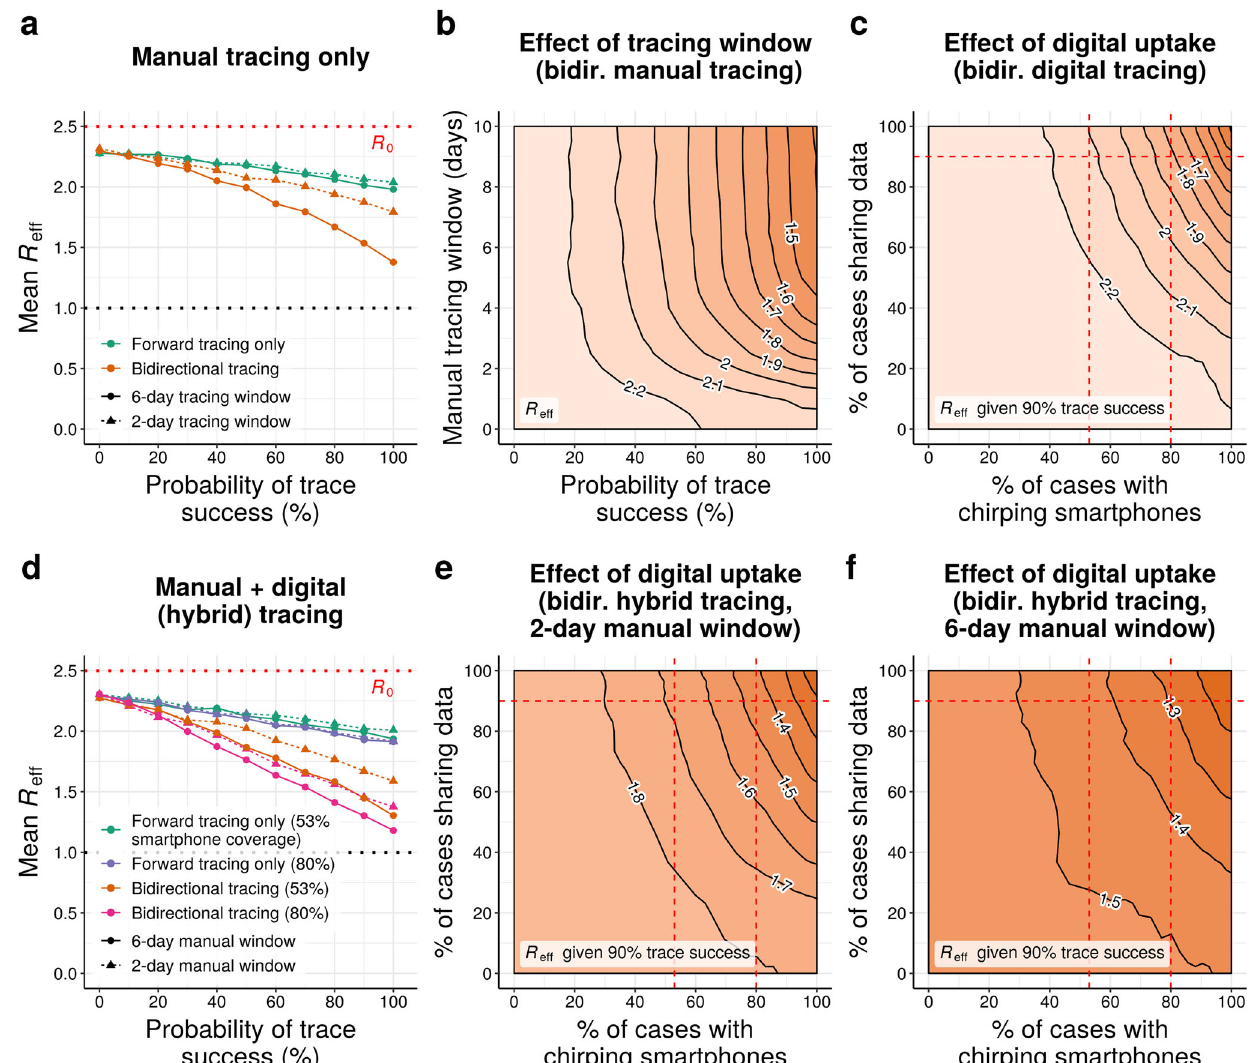
Fig. 2 Comparing forward and bidirectional contact tracing at R 0 = 2.5. a Mean R eff achieved by manual tracing with 2-day and 6-day manual tracing windows. b Neighbor-averaged contour plot, showing mean R eff achieved by bidirectional manual tracing as a function of the probability of trace success and the width of the manual tracing window. c Neighbor-averaged contour plot, depicting R eff achieved by digital exposure noti fi cation in the absence of manual tracing as a function of smartphone coverage and data-sharing, assuming 90% probability of trace success. d Mean R eff achieved using hybrid manual + digital tracing, assuming 90% data sharing and 53% or 80% smartphone coverage. e , f Neighbor-averaged contour plots, depicting R eff achieved by hybrid tracing as a function of smartphone coverage and data-sharing, assuming 90% probability of trace success and a e 2-day or f 6-day manual tracing window. All panels assume median disease parameters (Table 1). “ Probability of trace success ” refers to trace attempts that are not otherwise blocked by environmental transmission or fragmentation of the digital